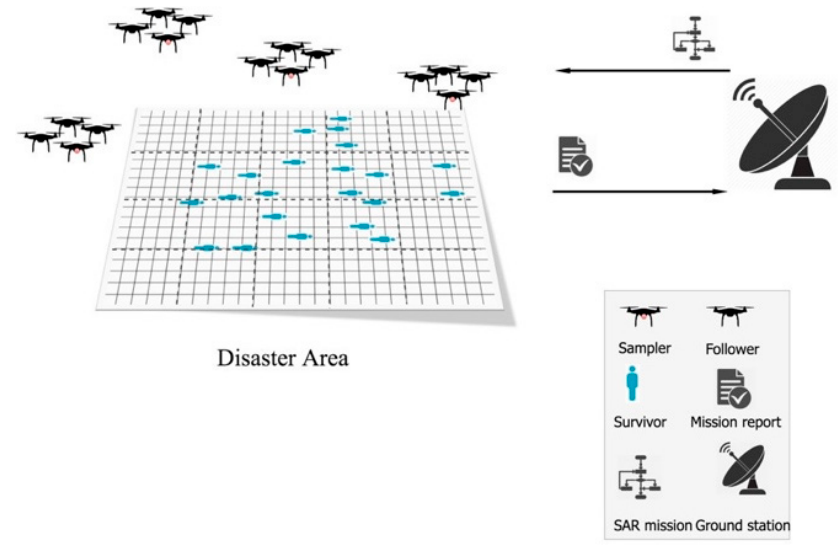
Figure 2. System overview. SAR, search and rescue mission.